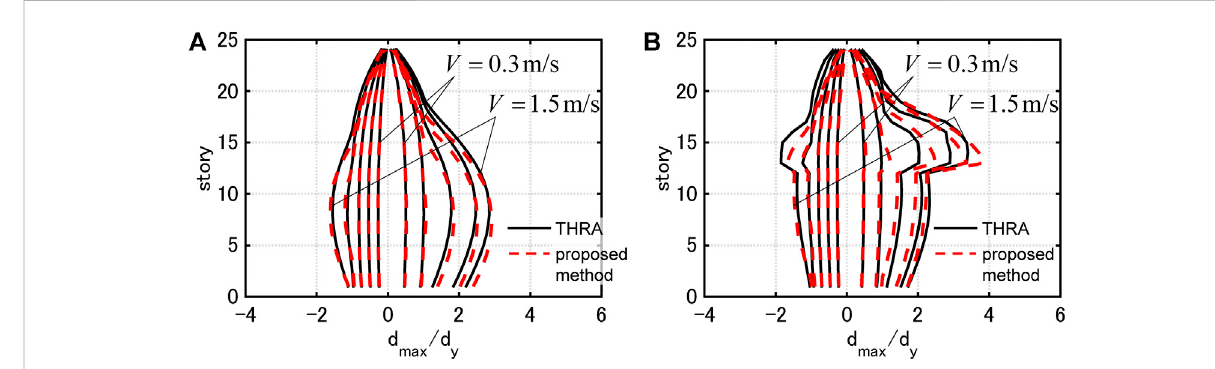
FIGURE 10 Maximum interstory drifts under critical PDI and those evaluated by proposed method, (A) Model 1 ( c 1 (cid:1) ... (cid:1) c 24 (cid:1) ( 60/24 ) × 10 7 Ns/m ) , (B) Model 2 ( c